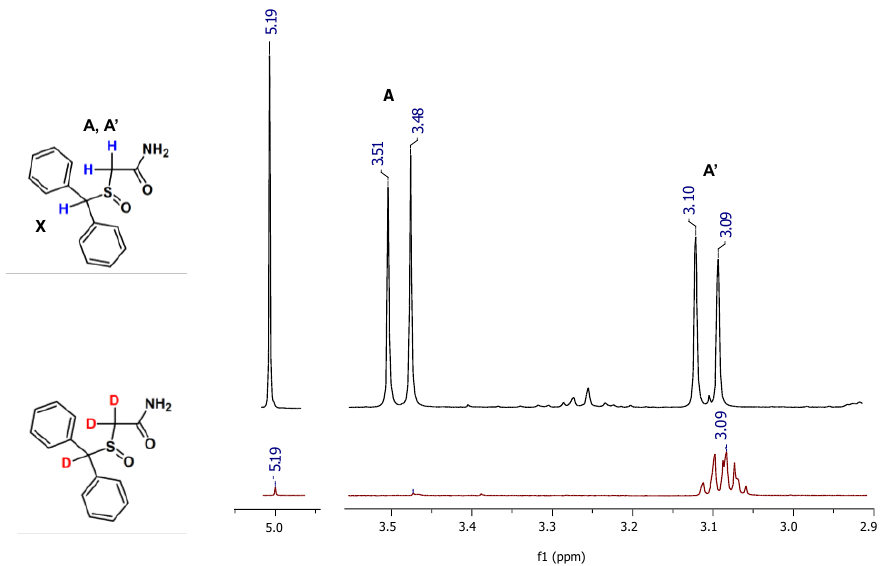
Figure 3. 1 H NMR spectra of armodafinil (black line) and armodafinil-d 3 (red line) samples dissolved in CDCl 3 .